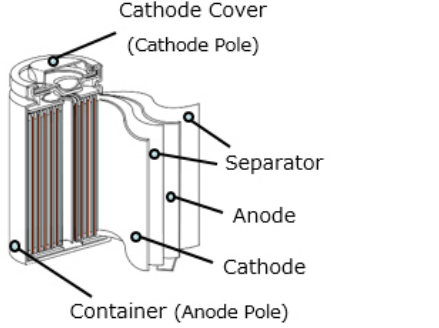
Figure 8. A rechargeable LIB with its components and function during charging and recharging (reprinted with permission from Ref. [44]).